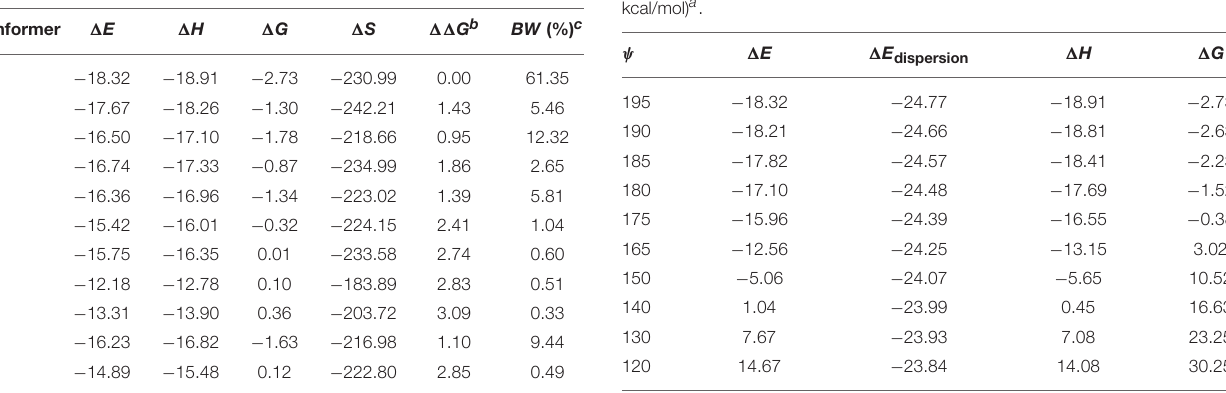
TABLE 5 | The change of binding energies ( 1 E) , binding enthalpies ( 1 H) , binding Gibbs free energies ( 1 G) , dispersion contribution to binding energies ( 1 E dispersion ), and the approximately estimated HB contribution to binding energies ( 1 E HB ) along with the rotation of the strongest HB in conformer 1